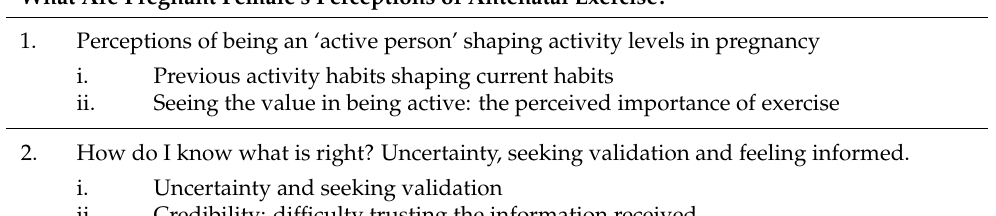
Table 2. Main themes and sub-themes. What Are Pregnant Female’s Perceptions of Antenatal